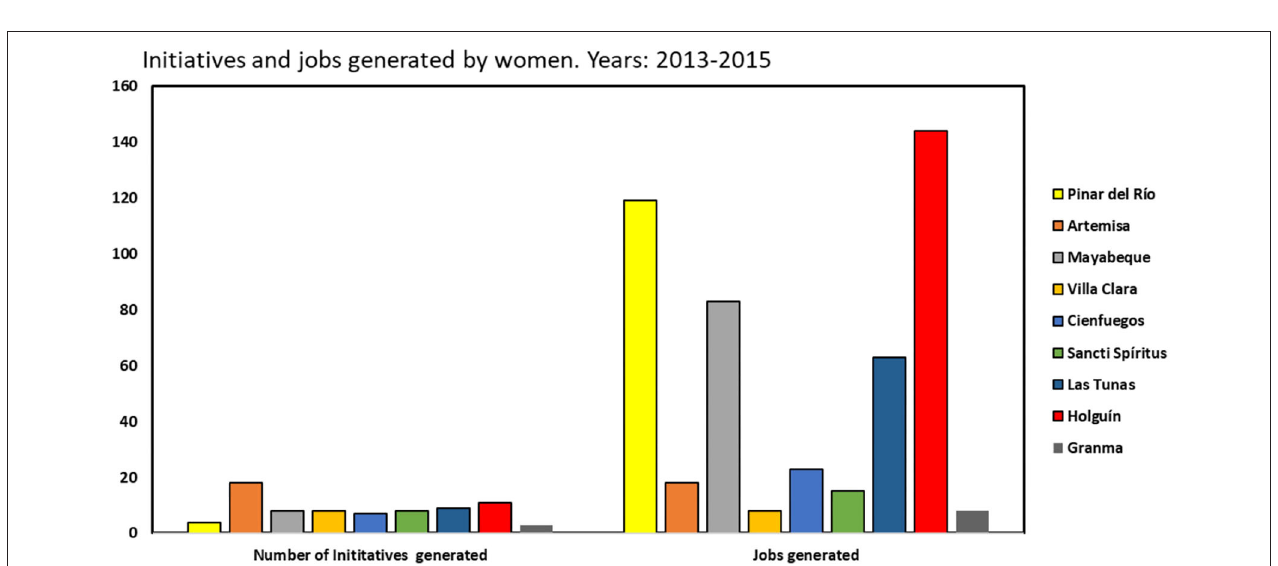
FIGURE 1 | Cuban provinces and municipalities where (PIAL) is active in its 4th phase.